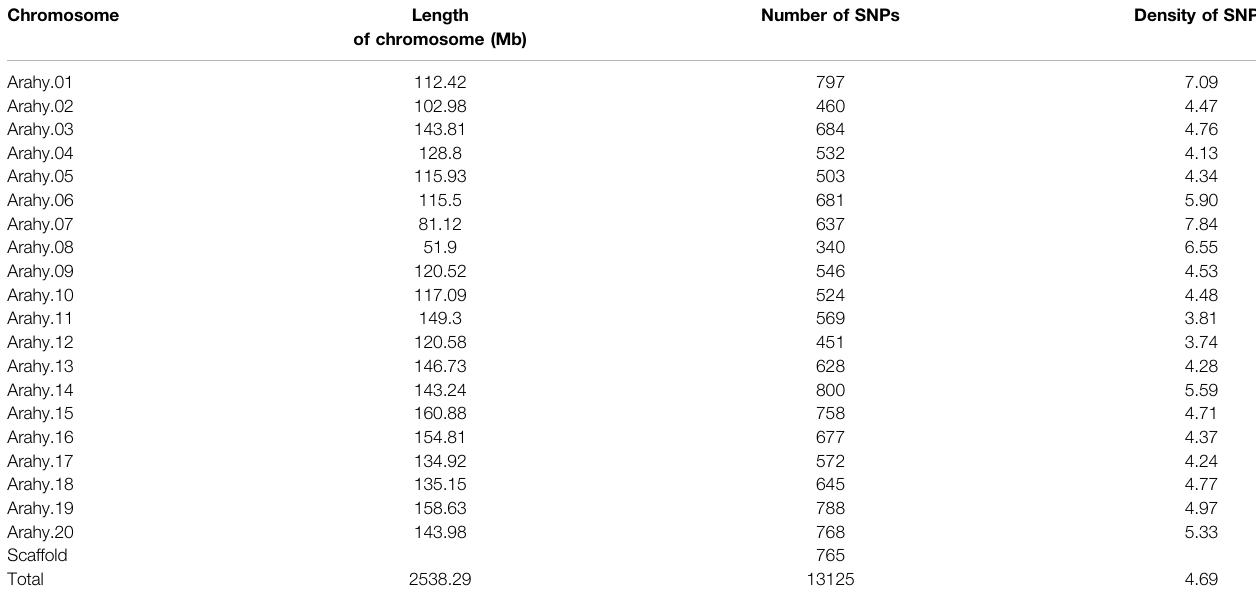
TABLE 2 | Distribution and density of SNPs on 20 chromosomes and scaffolds of peanut. Chromosome Length